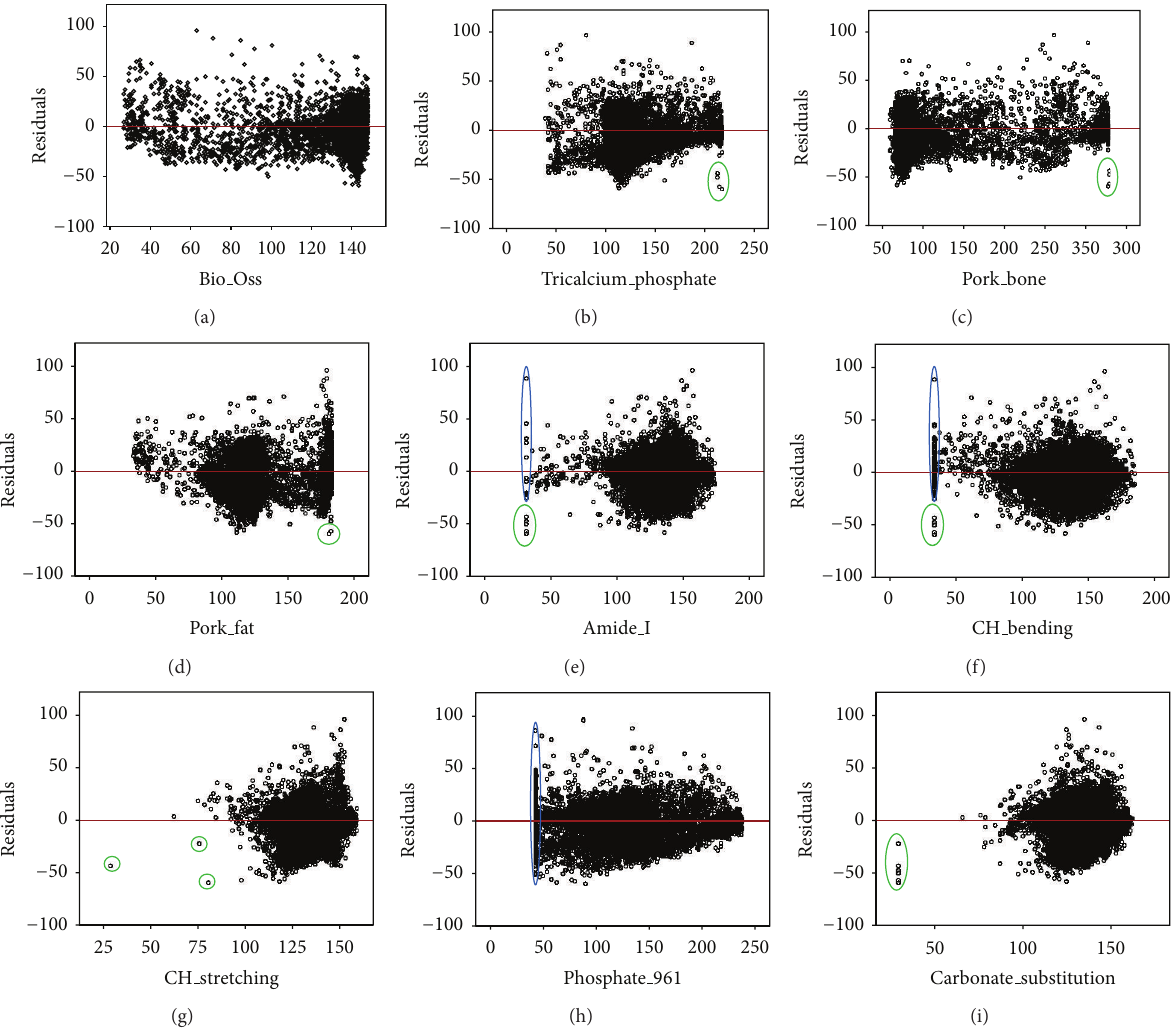
Figure 6: Residual plots and marked faulty measurements: (a) Bio Oss, (b) tricalcium phosphate, (c) pork bone, (d) pork fat, (e) Amide I, (f) CH bending, (g) CH stretching, (h) phosphate stretching at 961cm −1 , and (i) carbonate